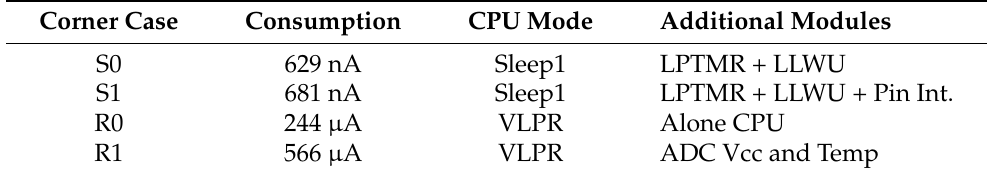
Table 6. Current consumptions measured on the MKL17Z256 in several working modes at 8 MHz or sleeping and required internal